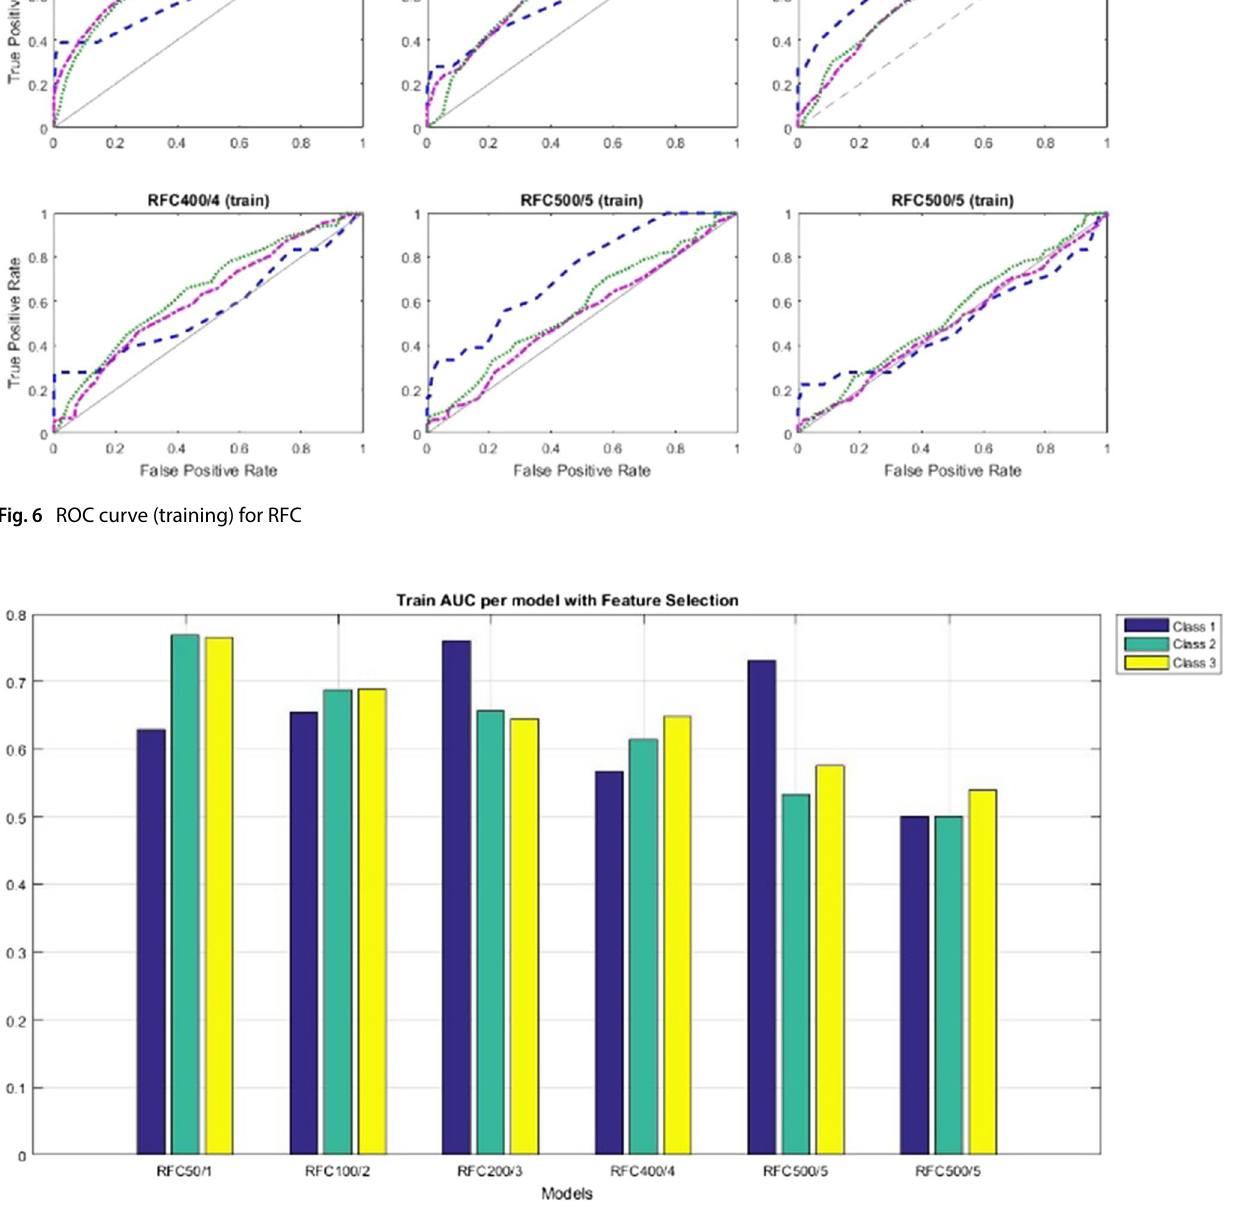
Fig. 7 AUC (training) for